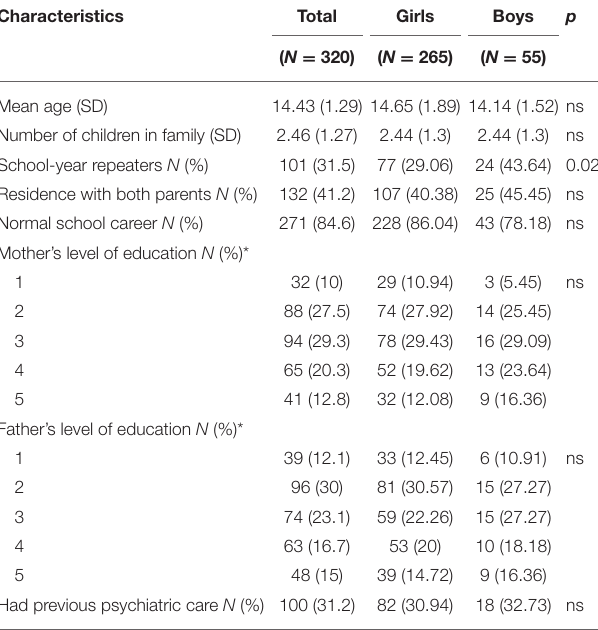
Gender Differences Related Suicide Attempt